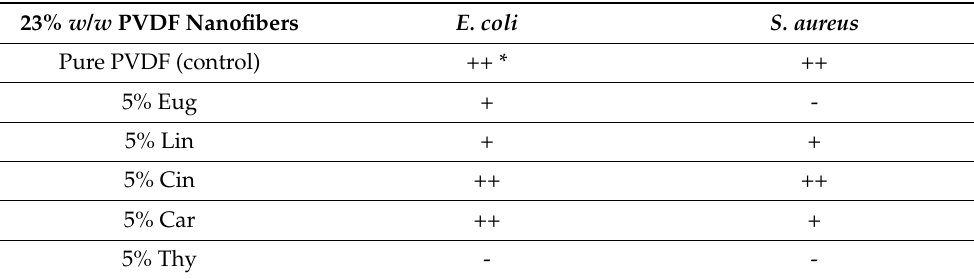
Table 5. Biofilm formation in the presence of PVDF nanofibers.